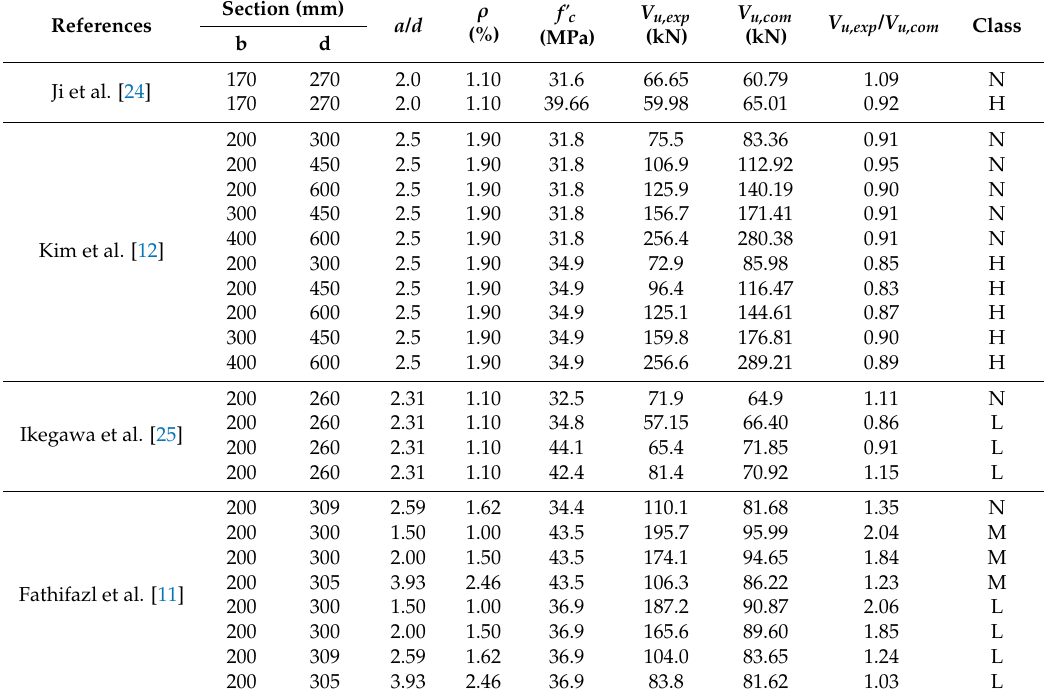
Table 7. Shear strength of the RC beam using a recycled aggregate concrete, from the